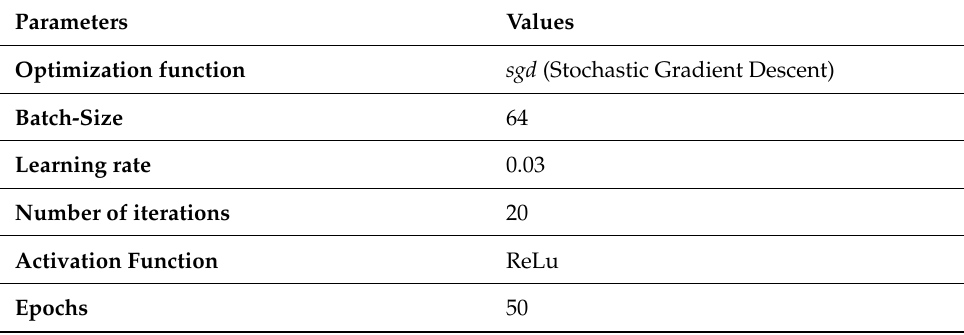
Table 1. Parameter settings for the